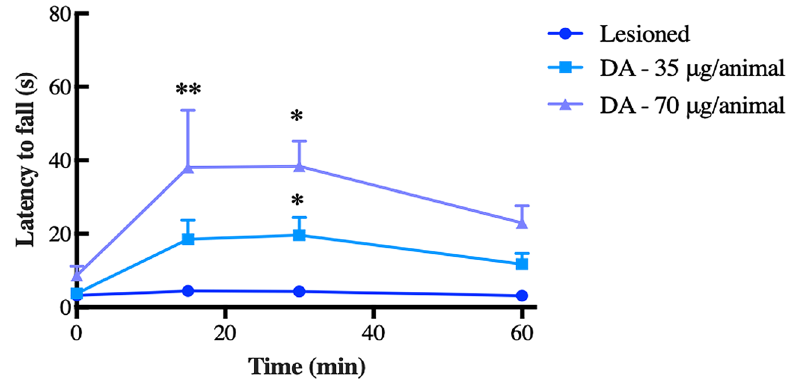
Figure 5. Latency to fall ( s ) from the rotarod in 6-OHDA-lesioned mice treated with saline or bulk dopamine (DA) either at 35 or 70 µg/animal. Data were submitted to ANOVA multivariate analysis, followed by Tukey post-hoc test. Significantly different from lesioned group, (*) p < 0.05 and (**) p < 0.01. N =